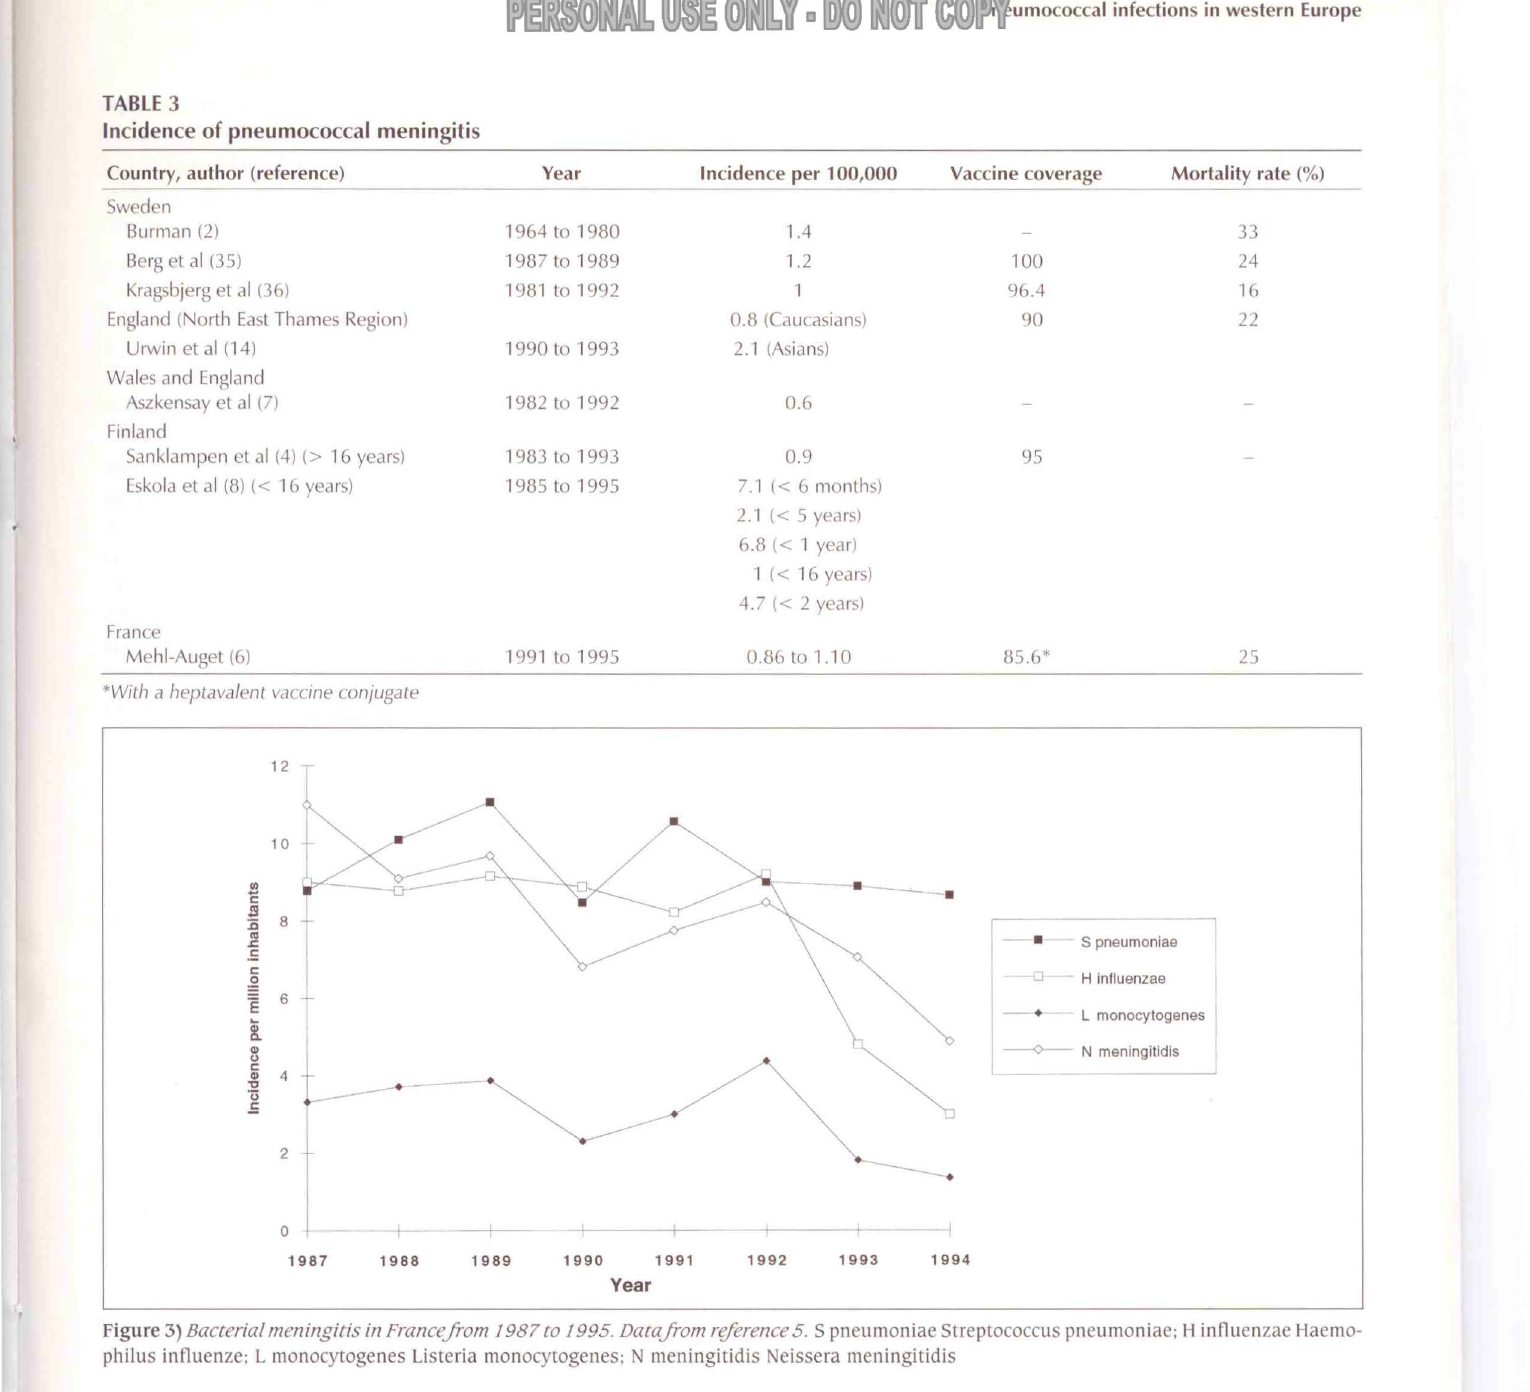
Incidence of pneumococcal meningitis